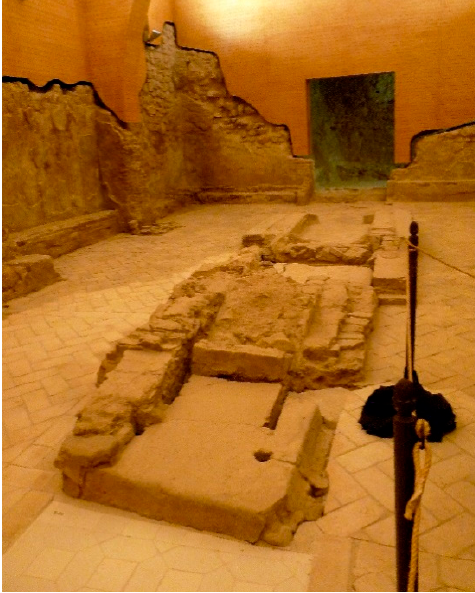
Figure 13. View of the remains of the tevah of Lorca Synagogue. Author’s photo.